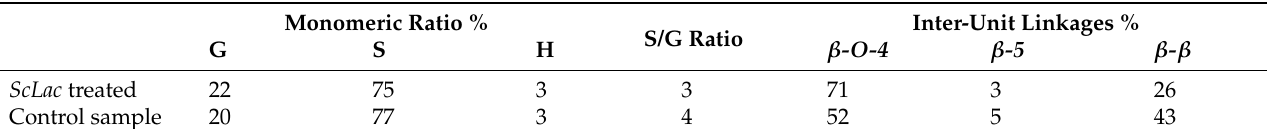
Table 4. Results of the HSQC analysis, the main subunits of lignin, as well as the linkages are shown as a % ratio of their integration signals.